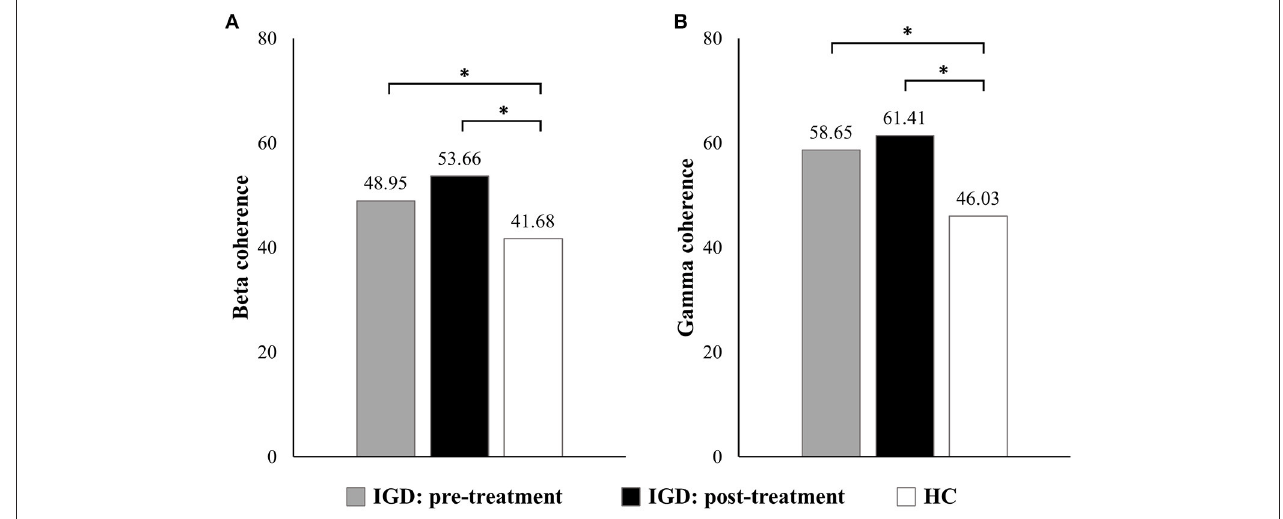
FIGURE 1 | Main effects on EEG intrahemispheric (A) beta and (B) gamma coherence before and after treatment. * P < 0.05.